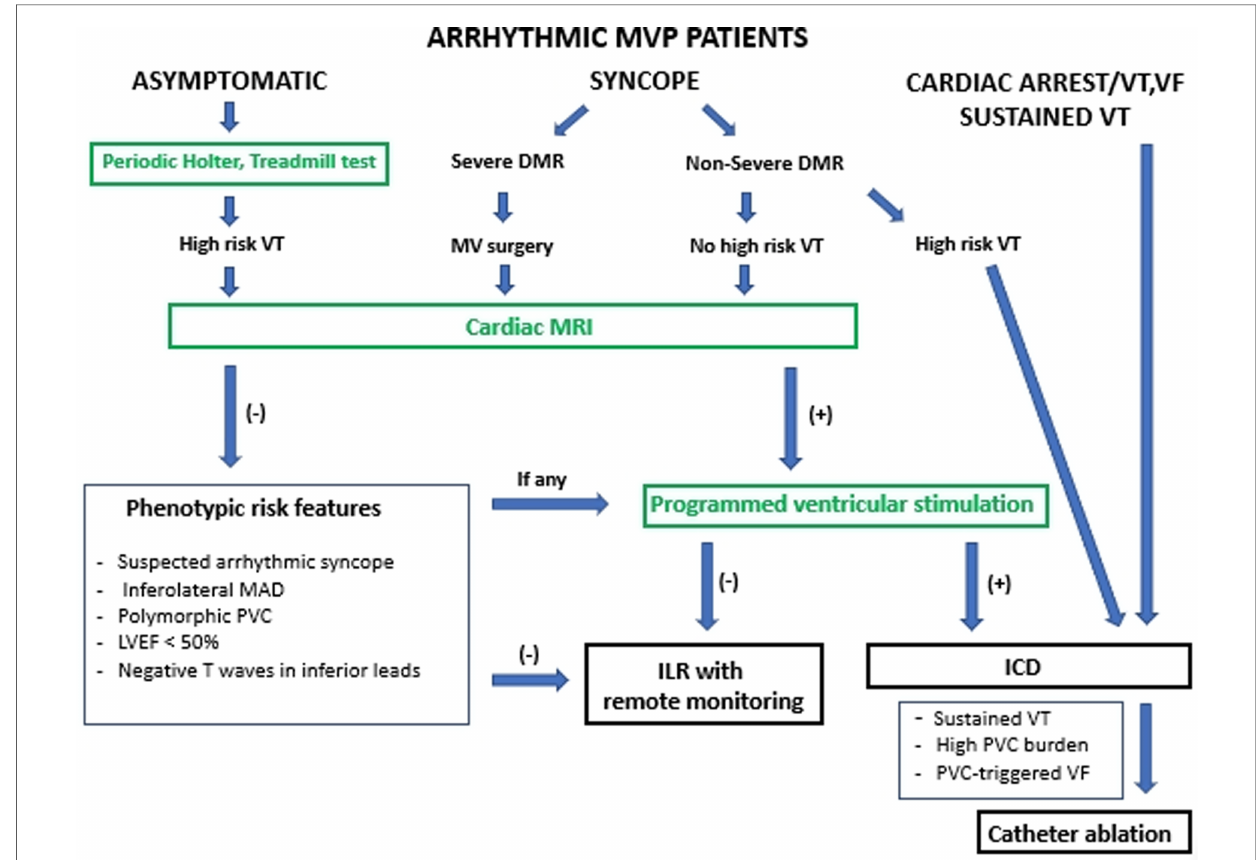
FIGURE 3 Risk strati fi cation in patients with arrhythmic MVP using clinical and imaging criteria represented by modi fi ed EHRA risk strati fi cation scheme (17). Arrhythmic MVP: the presence of MVP with or without MAD, frequent ventricular ectopy ( ≥ 5% of total beats), complex ectopy or sustained VAs in the absence of any other well-de fi ned arrhythmic substrate (e.g. active ischemia, ventricular scar due to another de fi ned etiology, primary cardiomyopathy or channelopathy); High risk VT: fast (>180 bpm) non-sustained VT, polymorphic non-sustained VT, Cardiac MRI: only LGE within the mitral apparatus (papillary muscles and peri-annular region) has a clear pathophysiological relevance. DMR, degenerative mitral regurgitation; ICD, implantable cardioverter de fi brillator; ILR, implantable loop recorder; LGE, late gadolinium enhancement; LVEF, left ventricular ejection fraction; MAD, mitral annular disjunction; MV, mitral valve; PVC, premature ventricular contraction; VA, ventricular arrhythmia; VF, ventricular fi brillation; VT, ventricular